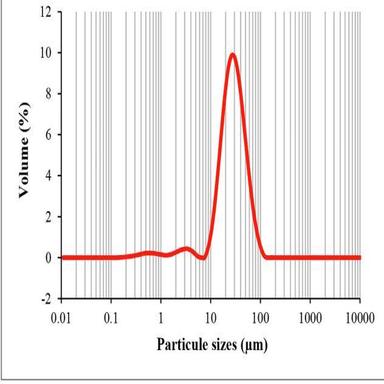
Cork particle distribution by granulometry test.